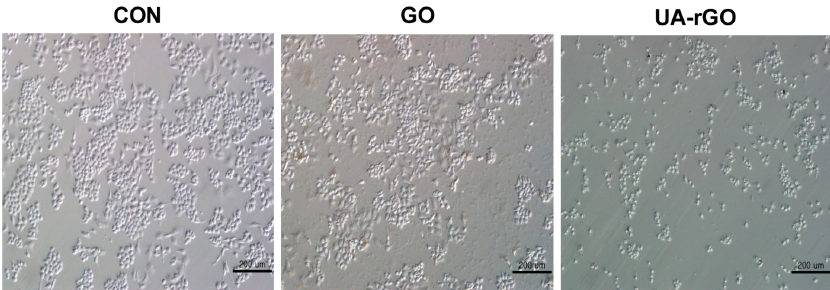
Figure 8. Morphology of human ovarian cancer cells treated with GO and UA-rGO. The morphology of A2780 cells treated with GO and UA-rGO (50 μ g/mL) for 24 h. The images were produced by interference contrast light microscopy.